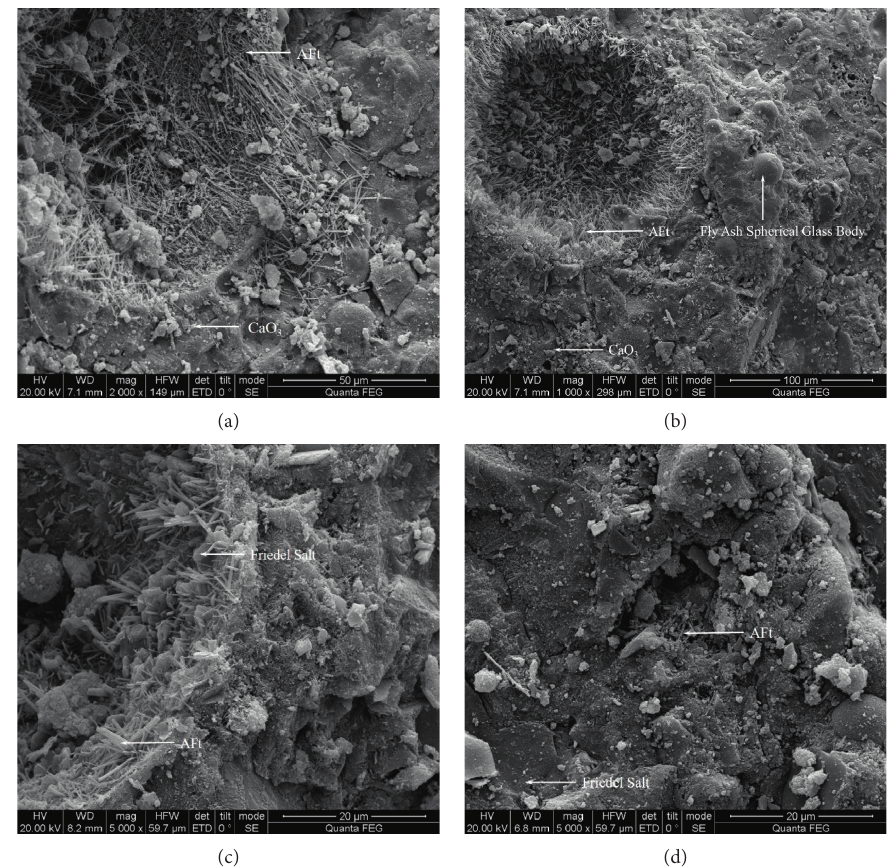
Figure 12: SEM images of concrete specimens. (a) OPC (NaCl-0%). (b) CFA-40 (NaCl-0%). (c) OPC (NaCl-3.5%). (d) CFA-40 (NaCl-